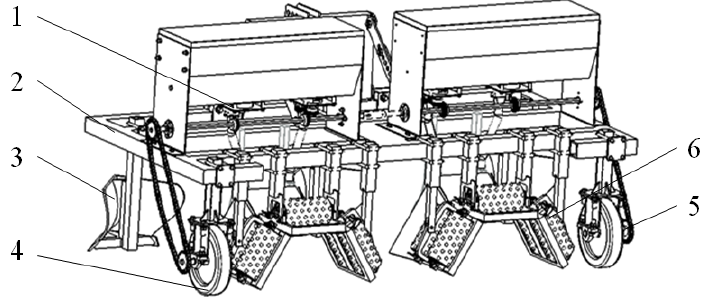
Figure 1. Schematic diagram of the overall structure of furrow-up fertilizer applicator. 1. Fertilizer apparatus; 2. Rack; 3. Furrower; 4. Ground wheel; 5. Transmission device; 6. Suppression device.